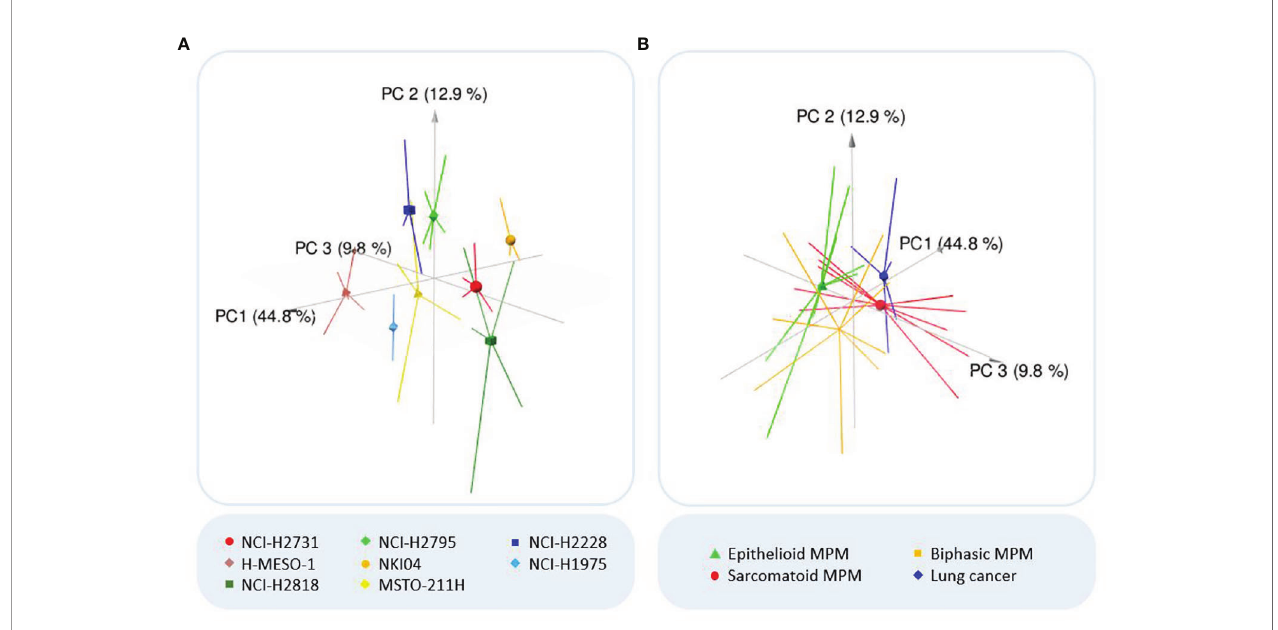
FIGURE 1 | Outcome principal component analysis (PCA). (A) Three-dimensional PCA plot of all analyzed cell lines. Colors of the cell lines: light/dark green = epithelioid MPM; red/brown = sarcomatoid MPM; yellow/orange = biphasic MPM; dark/light blue = lung cancer. (B) Three-dimensional PCA plot of the MPM subhistologies and lung cancer. PCA reduces the large number of variables to a few principal components (PCs), which account for the most variation in the data. As the fi rst three PCs account for most of the variation, the three-dimensional PCA plot shows clusters of samples based on their similarity. Consequently, the more distant the samples are, the more they differ (according to the variation explained by the axes). The symbols indicate the centroids of the sample